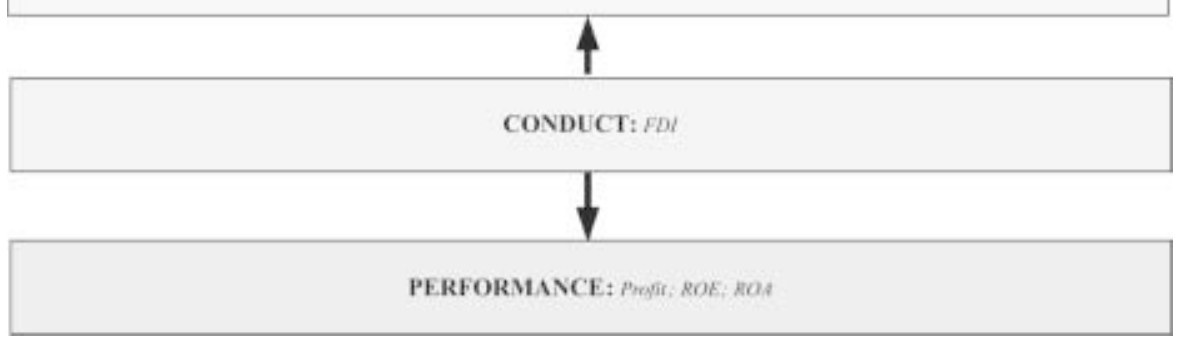
Fig 3 . SCP approach adapted for Lithuanian banking sector transformation